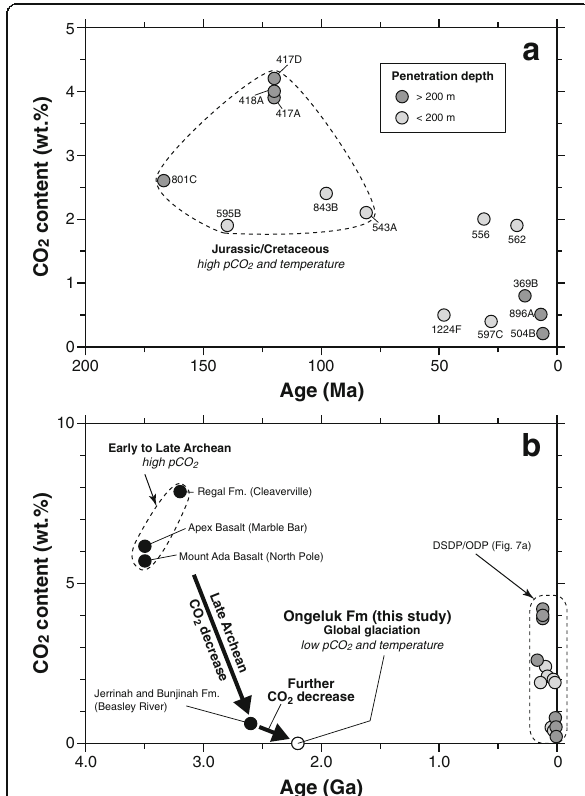
Fig. 7 Secular change of CO 2 (as carbonate) content in the altered subseafloor crust. a DSDP/ODP drill cores that penetrated basaltic basement (Alt and Teagle 1999; Gillis and Coogan 2011). The CO 2 content in the Jurassic/Cretaceous crusts is generally higher than that of younger crusts. Because the crusts with shallower penetration depth have large variation of CO 2 content, the crusts with penetration depth > 200 m is mainly discussed in the text. b The CO 2 content in Precambrian greenstones with geologically reconstructed depth > 1000 m from the ancient seafloor. Data from 3.5 Ga Apex Basalt in the Marble Bar area (Nakamura and Kato 2004), 3.5 Ga Mount Ada Basalt in the North Pole area (Kitajima et al. 2001; Terabayashi et al. 2003), 3.2 Ga Regal Formation in the Cleaverville area (Shibuya et al. 2012), 2.6 Ga Jeerinah and Bunjinah